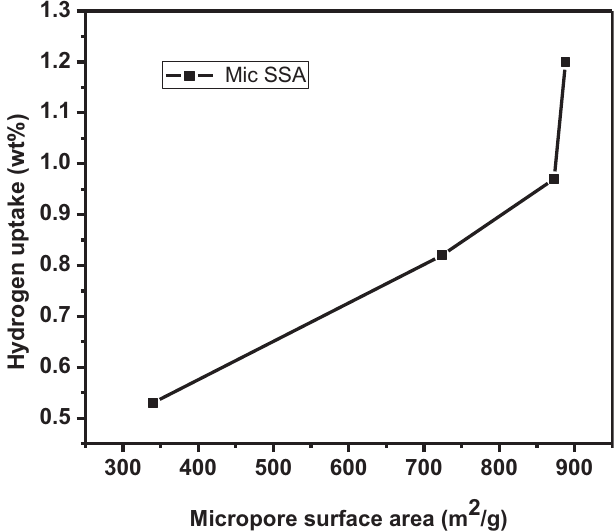
Fig. 8. Relationship between stored maximum H 2 content (wt. %) and micro-pore surface area (m 2 /g) in activated carbons at 30 ° C and 40 bar.